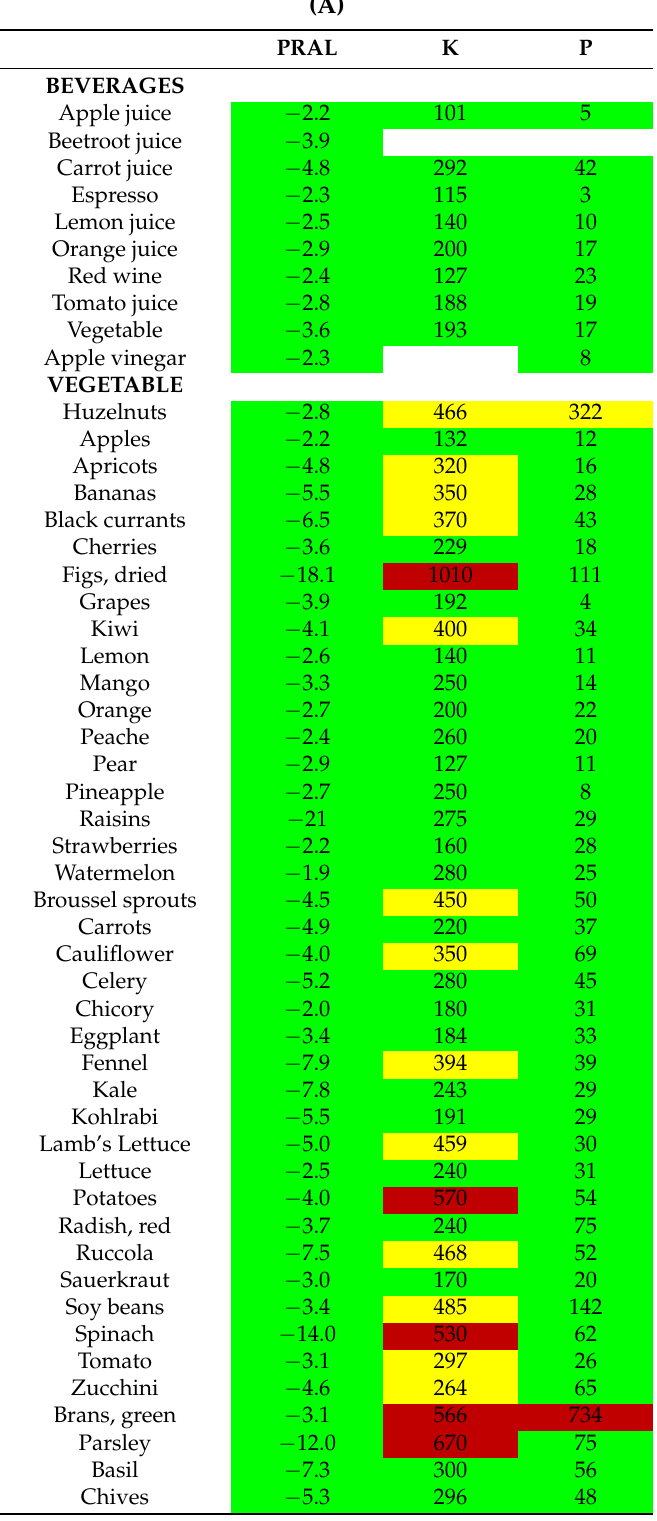
Table 4. ( A ) PRAL (Potential Renal Acid Load) from − 5 to − 2.0 mEq/100 g; ( B ) PRAL (Potential Renal Acid Load) from − 2.0 to 0 mEq/100 g; ( C ) PRAL (Potential Renal Acid Load) from 0 to 4.0 mEq/100 g; ( D ) PRAL (Potential Renal Acid Load) from 4.1 to 10 mEq/100 g; ( E ) PRAL (Potential Renal Acid Load) > 10 mEq/100